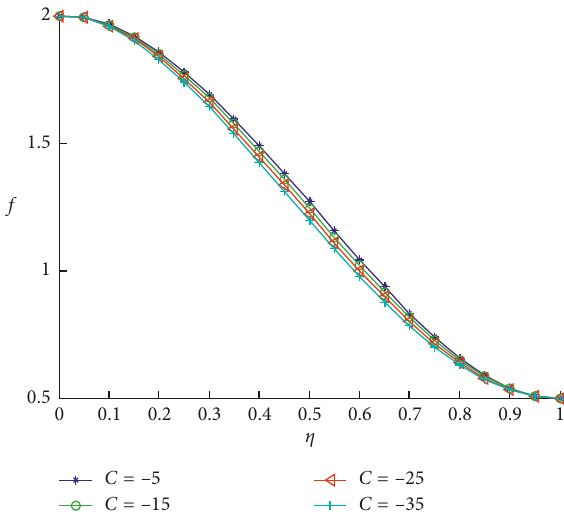
2 , S 1 , c 0 . 1 , Nb (cid:31) (cid:31) (cid:31)